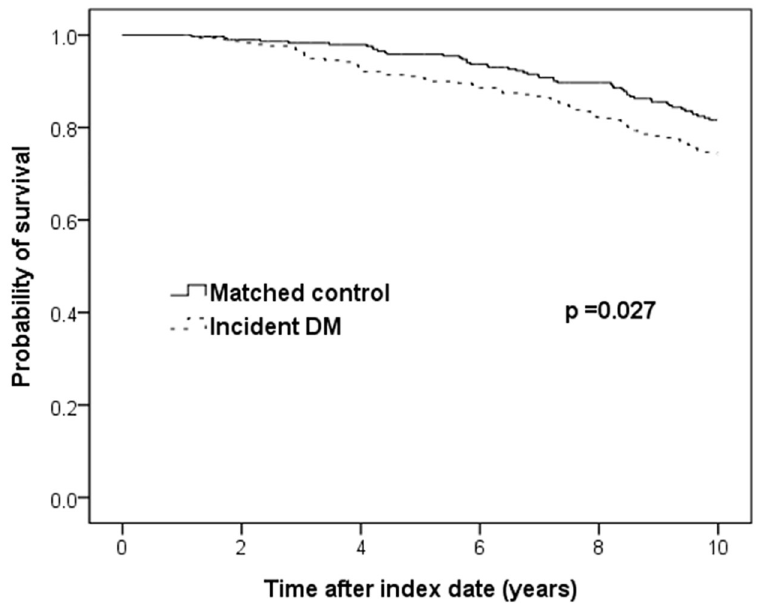
Fig 4. Kaplan-Meier curves for survival in COPD patients with incident DM and matched controls. COPD, chronicobstructive pulmonary disease;DM, diabetesmellitus.